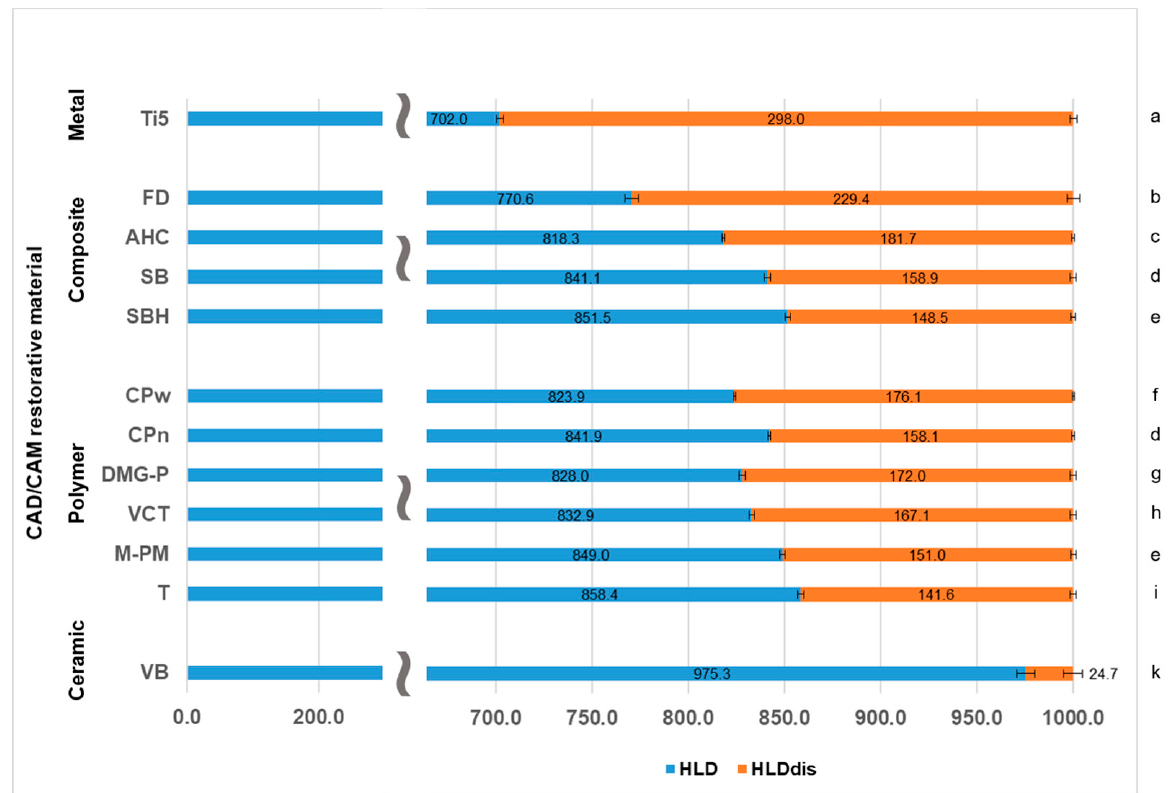
Figure 4. HLD and HLD dis data determined via Leeb hardness determination. For HLD , the scaling was interrupted (blue bars) to allow a more precise interpretation and view on significantly different HLD dis values. Identical lowercase letters on the right side denote no significant difference among CRMs ( p > 0.05). Parts of this data for Ti5, AHC, SB, SBH, VCT, M-PM, T, and VB were published